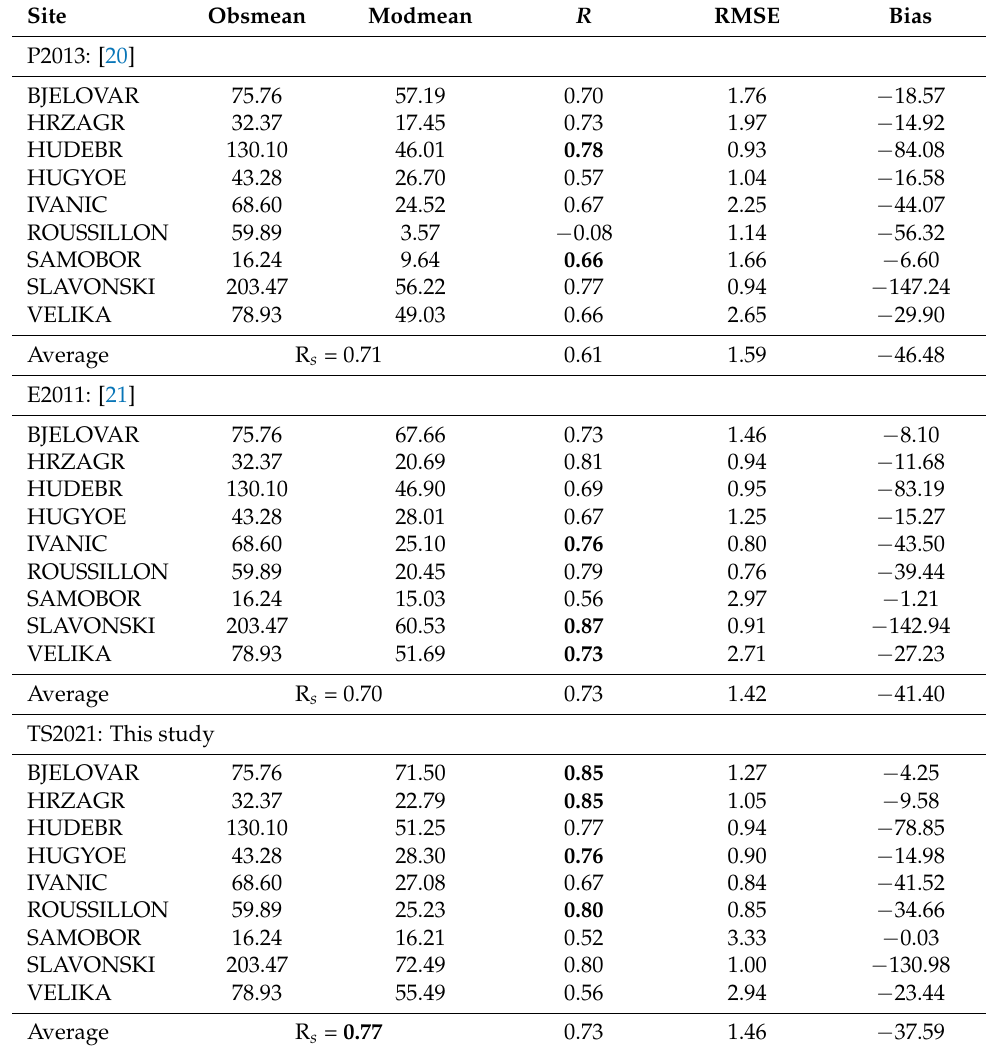
Table 6. Statistical scores: correlation R , root mean squared error RMSE and bias, calculated for each station where pollen measurements are available, for the three tested emissions schemes. For the correlation, the best value is in